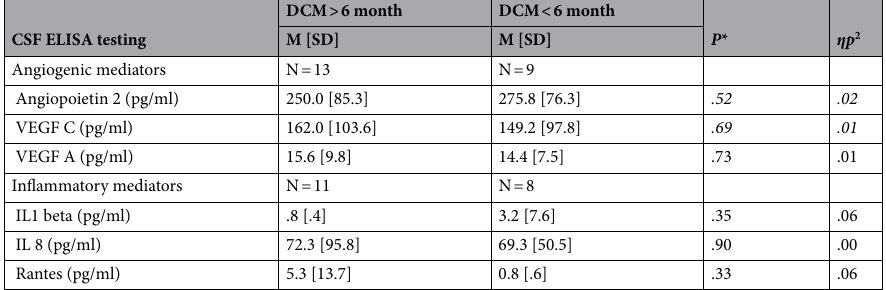
Table 4. CSF ELISA testing of patients (DCM) > < 6 month. CSF cerebrospinal fluid, DCM degenerative cervical myelopathy, pg/ml picogram per milliliter, M mean , SD standard deviation, TAAA thoracic-abdominal aortic aneurysm. * p values reflect the univariate post-hoc between group tests revealed by the MANOVAs; ηp 2 = partial eta squared effect size. Italic values indicate significance level of p <